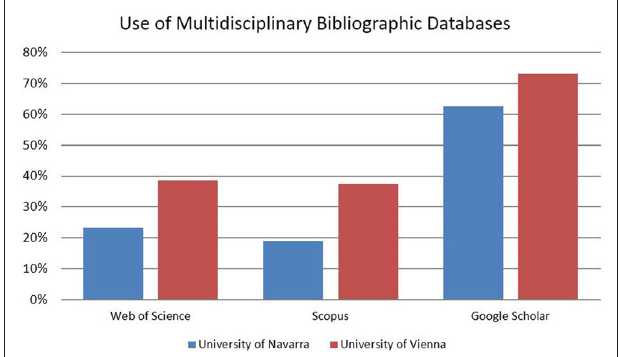
FIGURE 2 | Use of multidisciplinary bibliographic